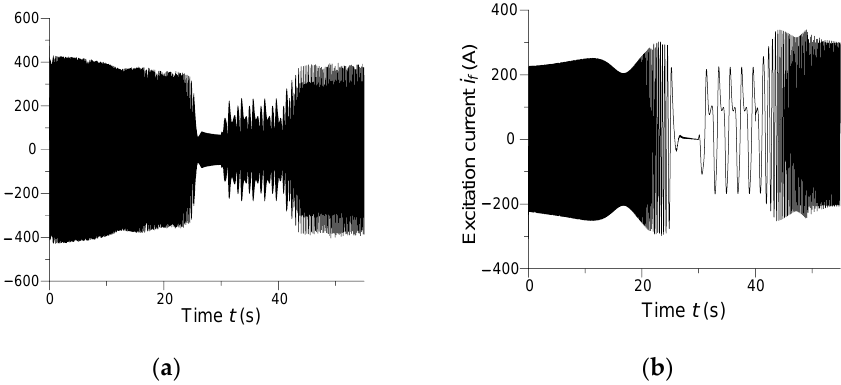
Figure 9. Instantaneous current waveforms of: ( a ) phase A of the synchronous motor armature; and ( b ) synchronous motor excitation.